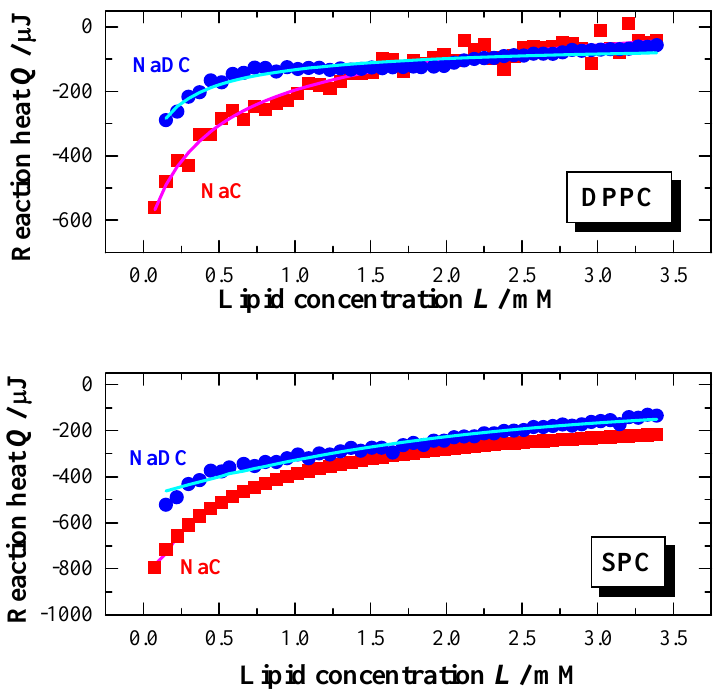
Figure 6. Partition experiment: Titration of a lipid dispersion (syringe) of a concentration of 20 mM, DPPC (top) and SPC (bottom), into a NaC (10 mM) or NaDC (4 mM) solutions in water at T = 60 ° C ( pH 7.5). Injection scenario: 50 injections à 5 μ l. The plots represent the change in reaction heat Q of each injection versus lipid concentration L in the cell (adapted from [56, 59]). The full lines were obtained from simulations using the partition model described in the